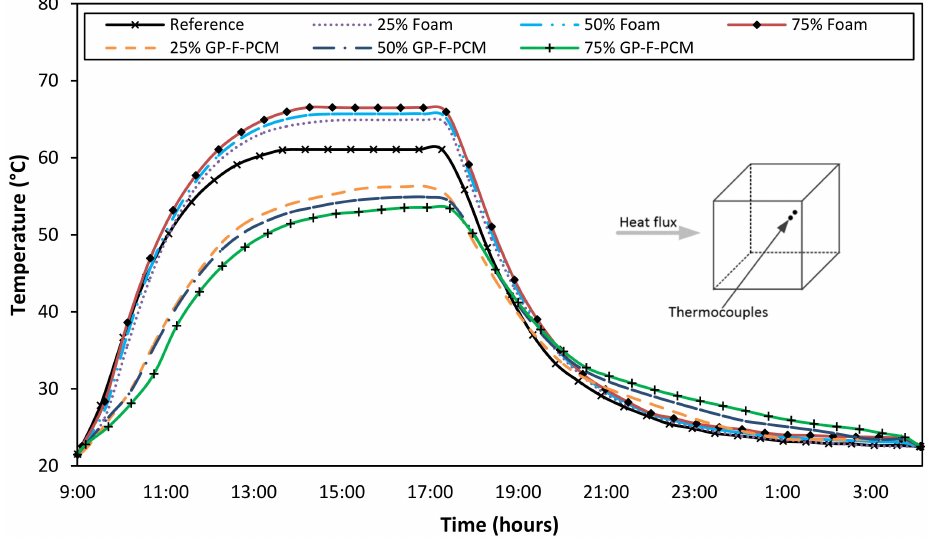
Figure A3. Comparison of temperature variations at the 4th side of all the